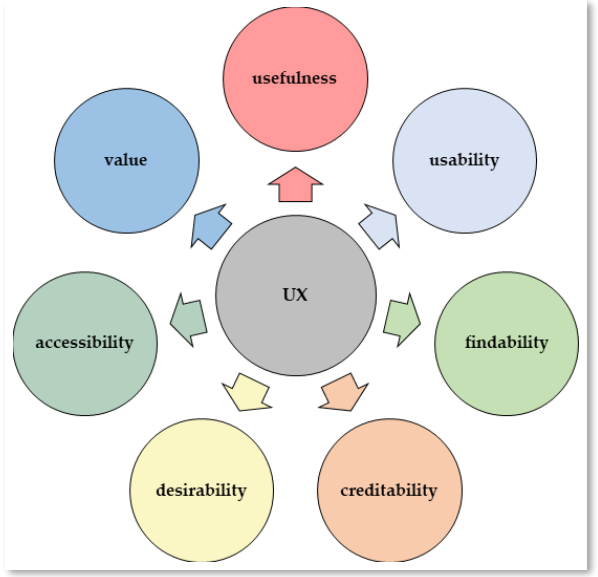
Figure 3. User experience factors.